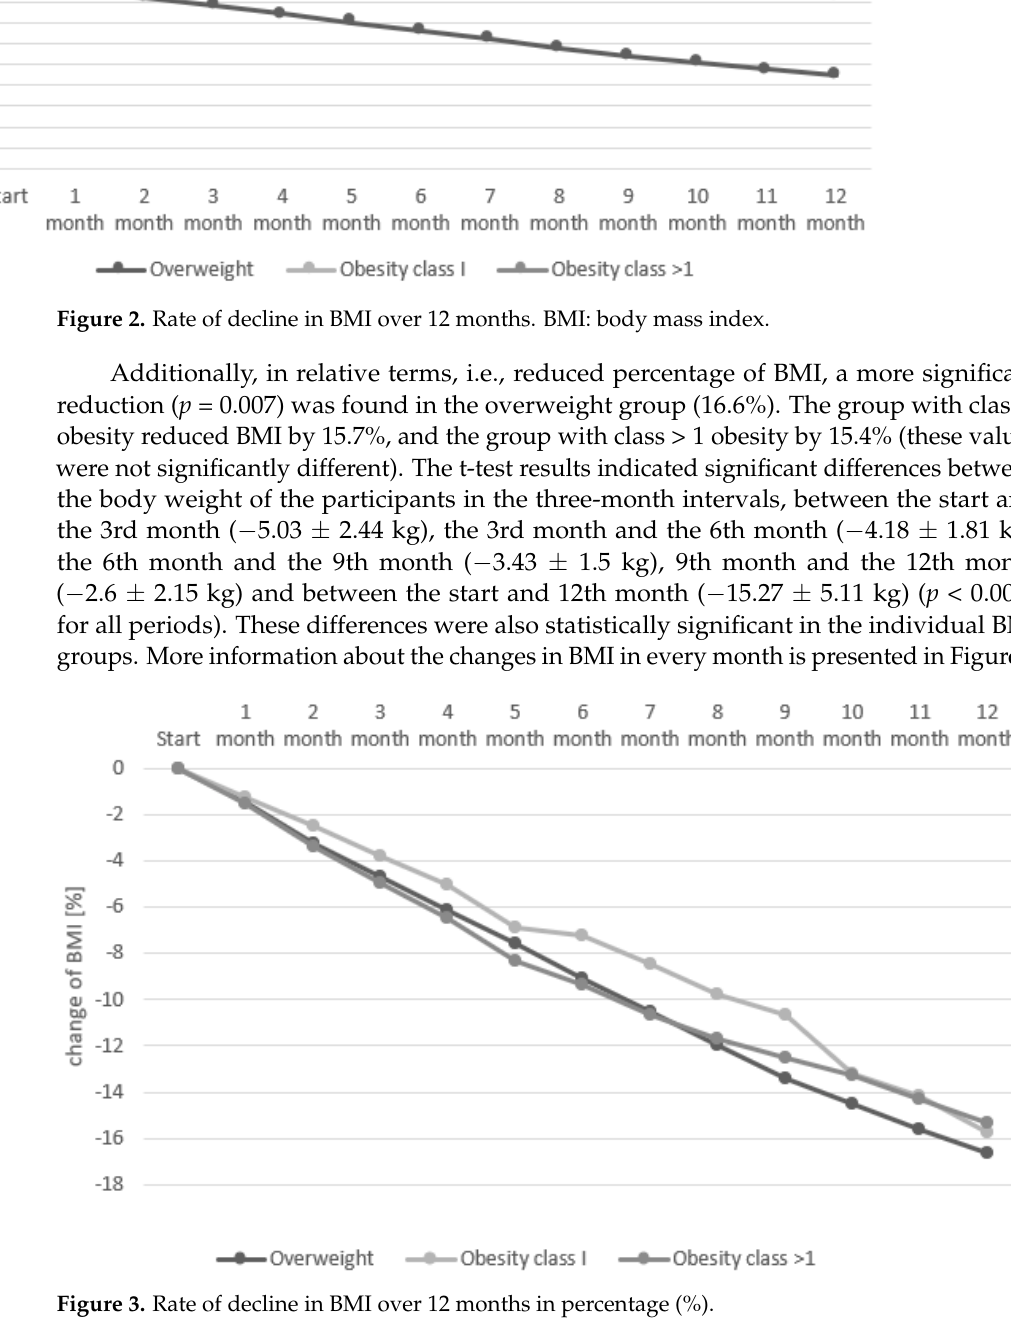
Figure 3. Rate of decline in BMI over 12 months in percentage (%). In order to evaluate the effectiveness of weight reduction in each BMI group, we as- sumed the attainment of normal weight, a reduction in body weight by one baseline de- gree, and a relative weight reduction expressed as a percentage in order to qualify indi- viduals as having achieved a weight reduction effect at a certain level. The first way was to determine how many individuals of each BMI group reduced their weight to a normal BMI, i.e., less than 25. In the overweight group, the final normal BMI was achieved by 86.3% of individuals; in the group with class 1 obesity, it was achieved by 11.9%; in the group with obesity class > 1, it was achieved by 0.9% of individuals. A second way to determine the success of the intervention was to reduce one’s BMI by one baseline degree. In the overweight group, this effect was demonstrated by 86.3% of individuals, in the class 1 obesity group by 99.2% of individuals, and in the class > 1 obesity group by 78.8% of individuals. The other four ways to determine success in weight reduction were to reduce baseline BMI by at least 5%, 10%, 15% and 20%. All participants achieved at least a 5% reduction in BMI, and almost all achieved at least a 10% reduction. More participants in the overweight group achieved at least a 15% and 20% reduction in BMI compared to the other two groups (Table 5). Table 5. Effectiveness of a 12-month weight reduction program as expressed in changes in BMI values.